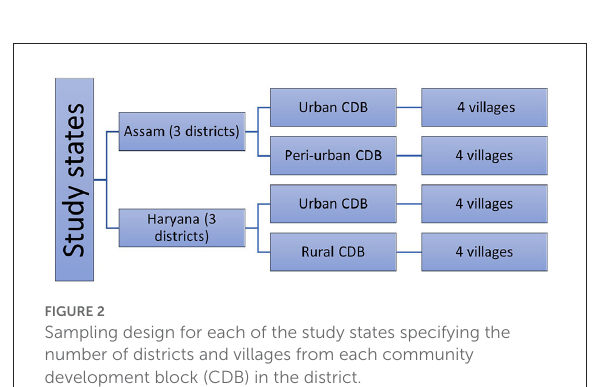
FIGURE2 Sampling design for each of the study states specifying the number of districts and villages from each community development block (CDB) in the